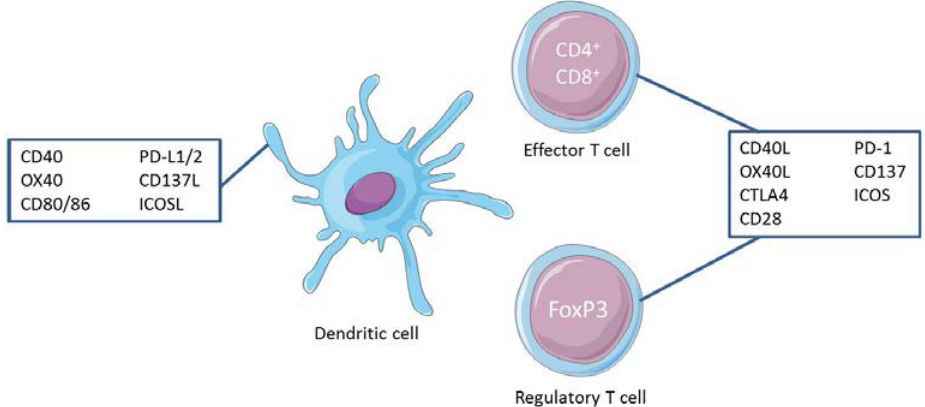
Figure 1. Costimulatory molecules expressed on antigen-presenting cells (APCs) and their ligands on effector and regulatory T cells.